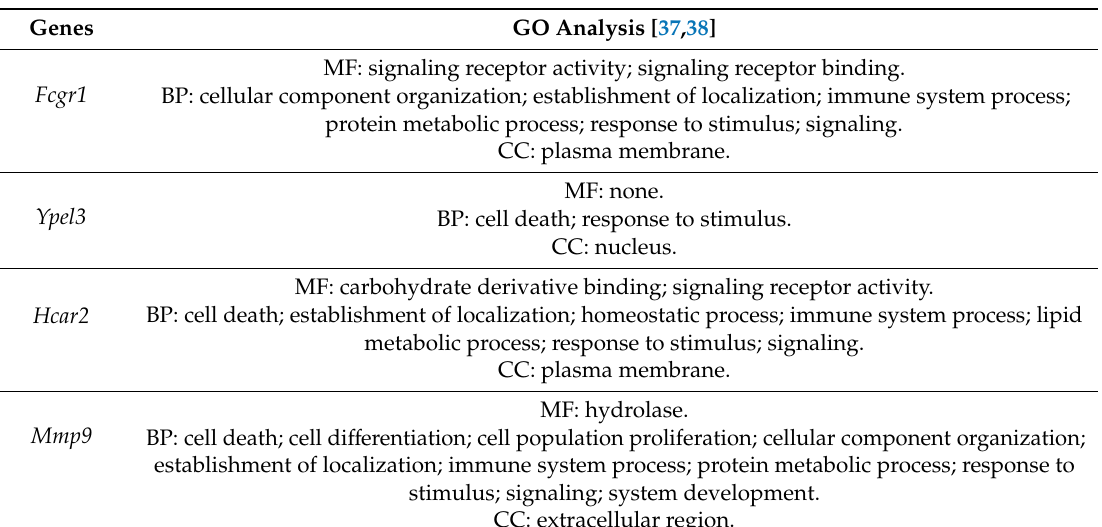
Table 6. GO analysis of dcEF-sensitive